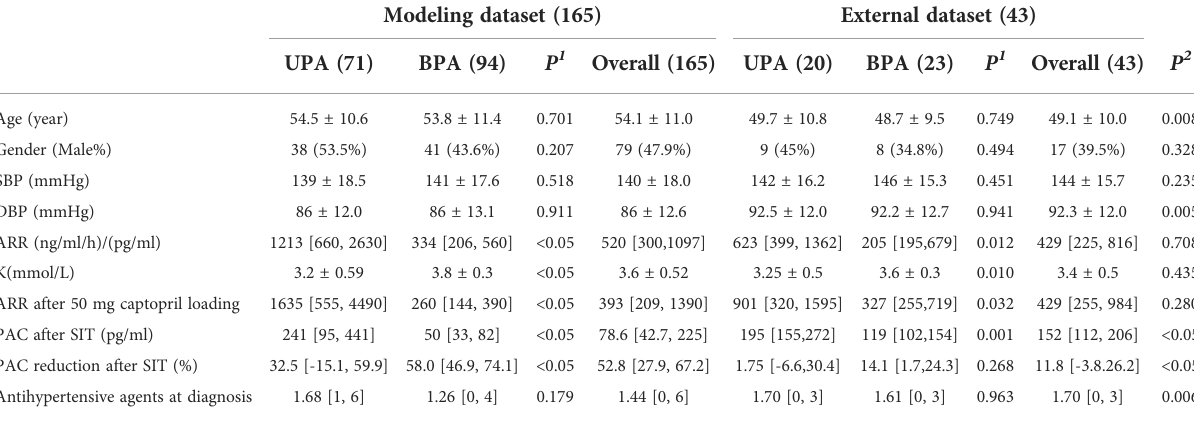
TABLE 1 Basic characteristics of primary aldosterone patients in the modeling dataset and external